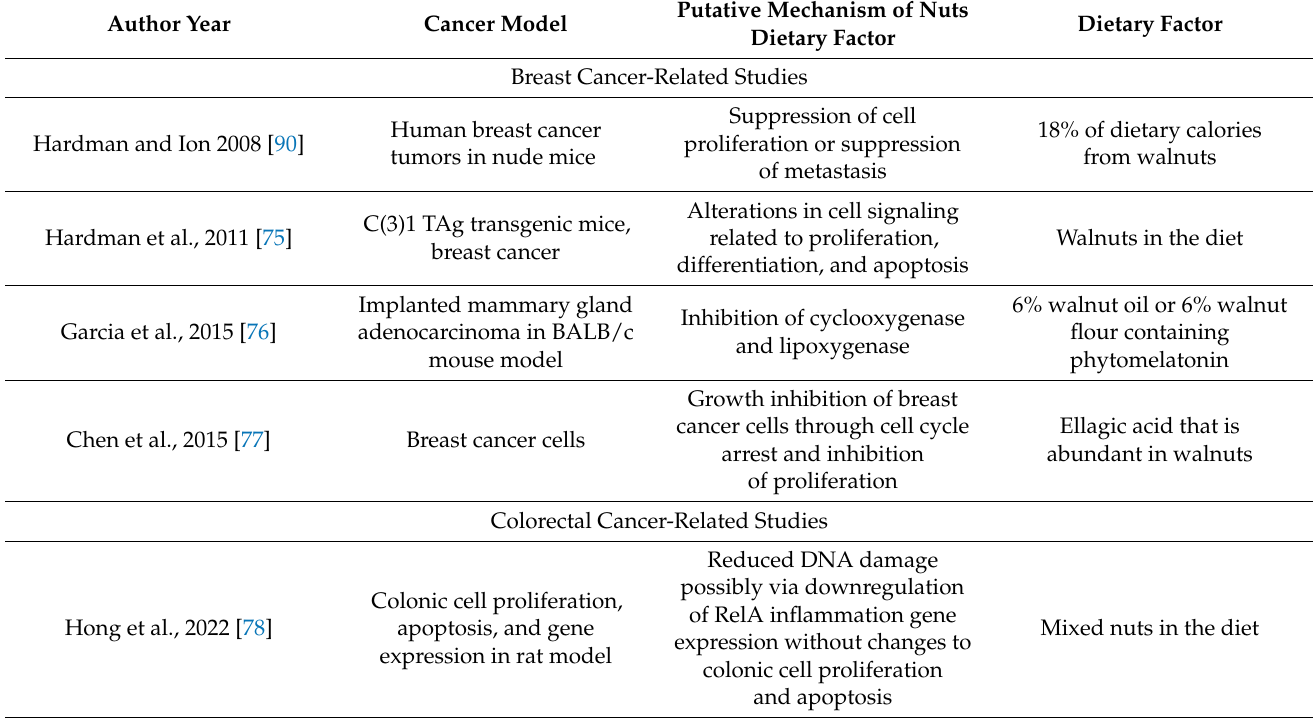
Table 2. Potential anticancer properties of nuts based on preclinical